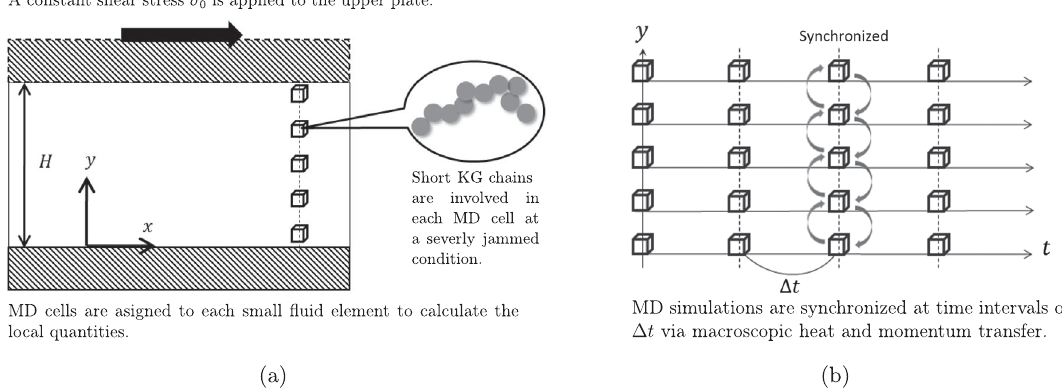
FIG. 1. The schematic of (a) the geometry of the problem and (b) the time